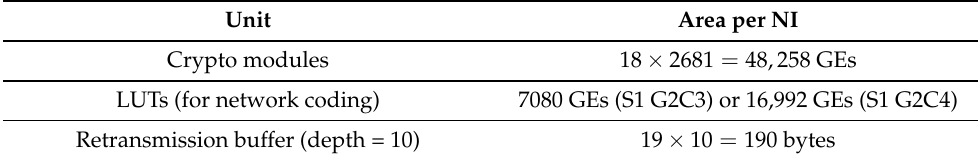
Table 6. Overview of area